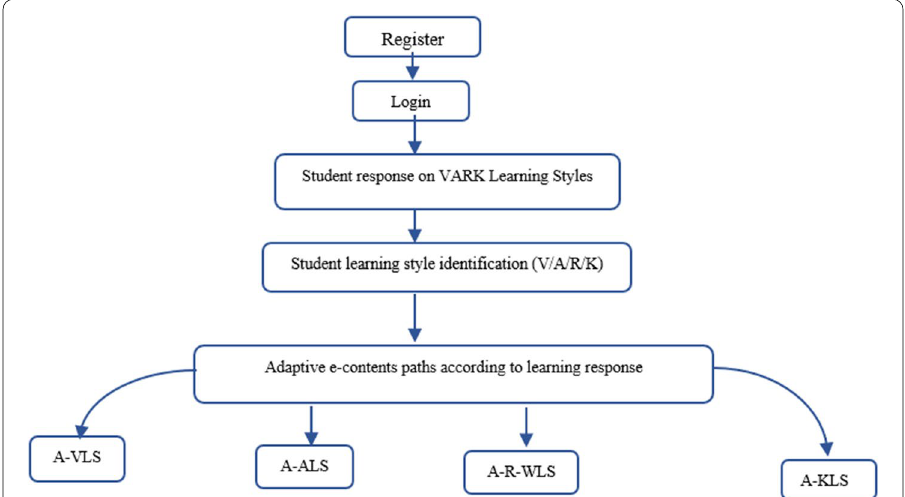
Fig. 5 Roles and deployment diagram of the adaptive e‑learning